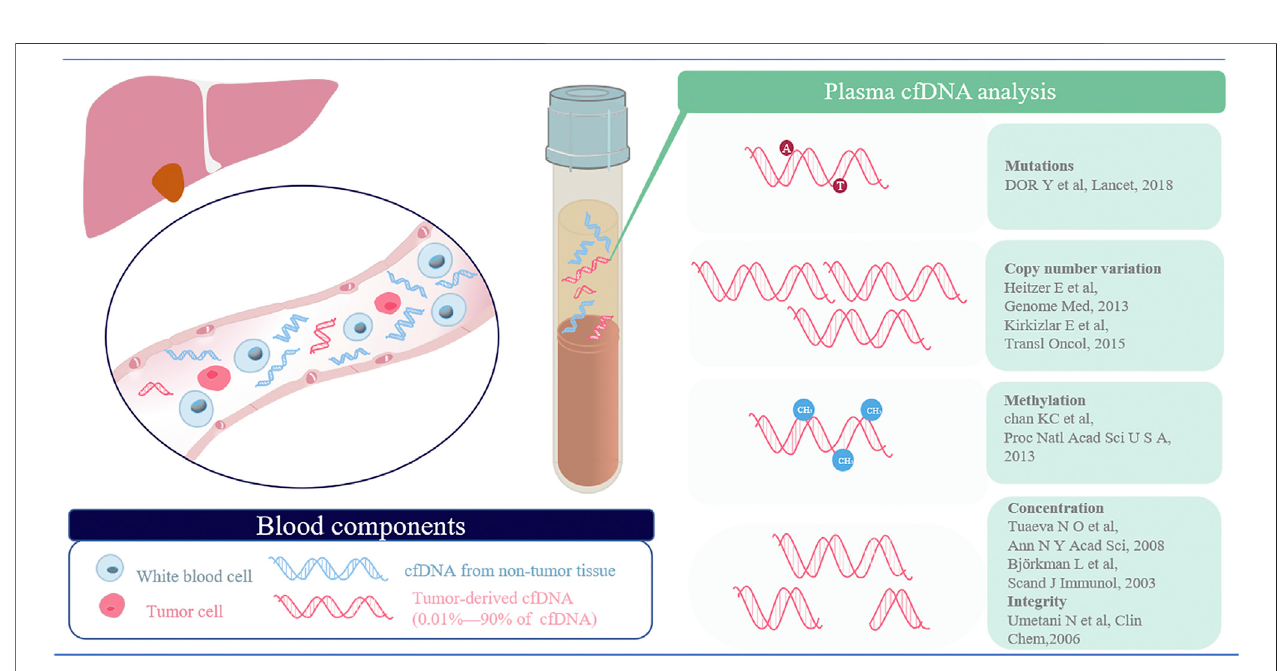
FIGURE 2 | Overview of the methods employed in the detection of different cancer-associated alterations. cfDNA in the plasma captures different cancer- associatedchanges,includingmutations,copynumberaberrations,alterationsinDNAmethylationandalteredDNAfragmentationpatterns(concentrationandintegrity).